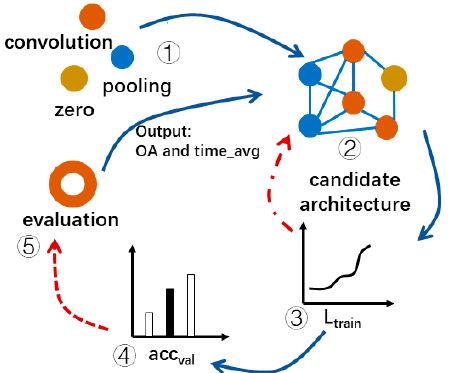
Figure 9. The process of the architecture search in this paper.